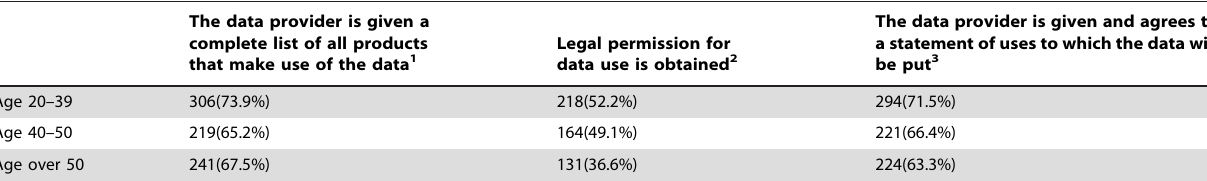
Table 27. Using others’ data by age group.